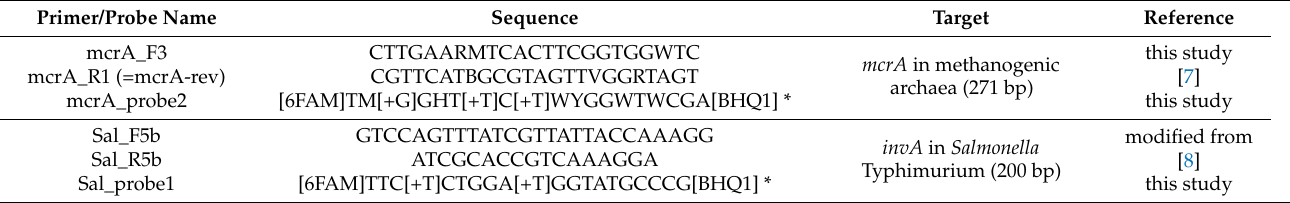
Table 1. The list of primers used in this